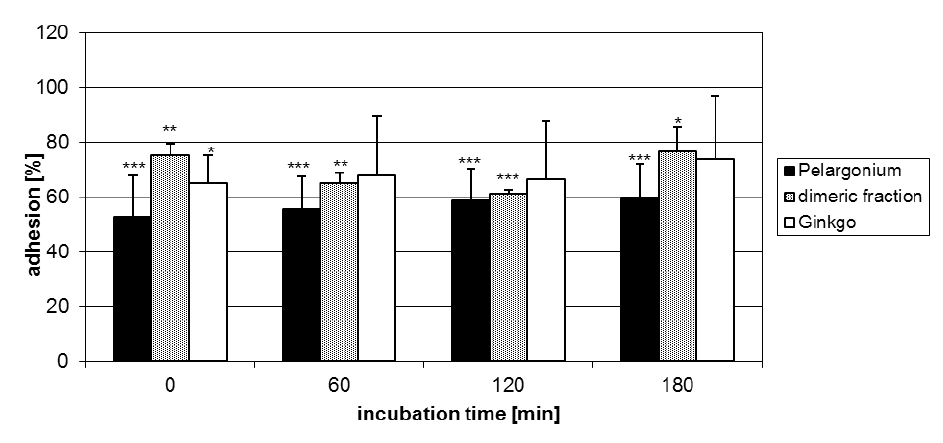
Figure 6. Effect of prodelphinidin samples on the adhesion of calcein-AM stained GAS to human HEp-2 cells as assessed by FACS analysis. Data represent the mean ± SD of epithelial cells that showed fluorescent bacteria and are derived from at least three independent experiments (* p < 0.05; ** p < 0.01; *** p <